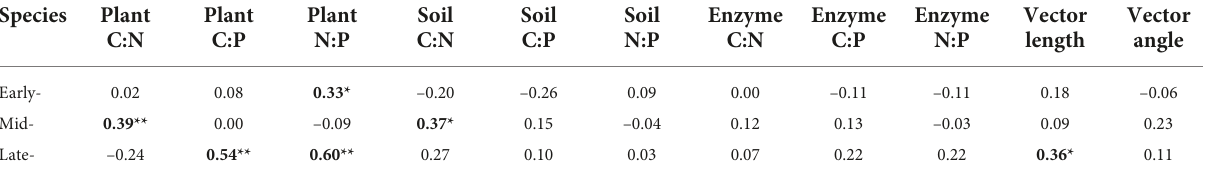
TABLE 1 Relationships of shoot biomass with plant, soil, and enzyme C-N-P stoichiometry of early-, mid-, and late- species ( n =